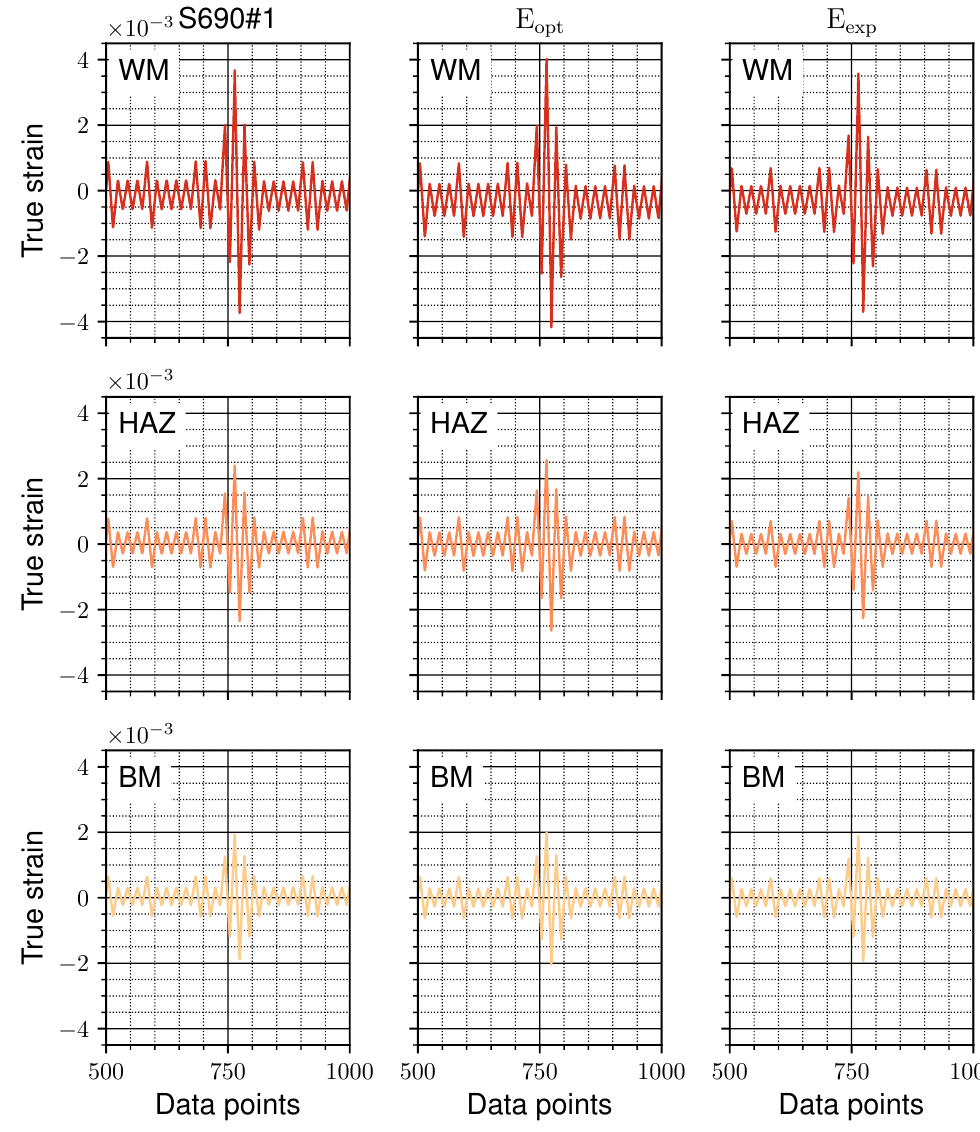
Figure 9. Visual comparison between the measured and simulated (V–C) strain signal of the validation experiment. The strain results correspond to specimen S690#1. Differences in the mean strain are caused by the development of ratcheting strain during the physical and numerical